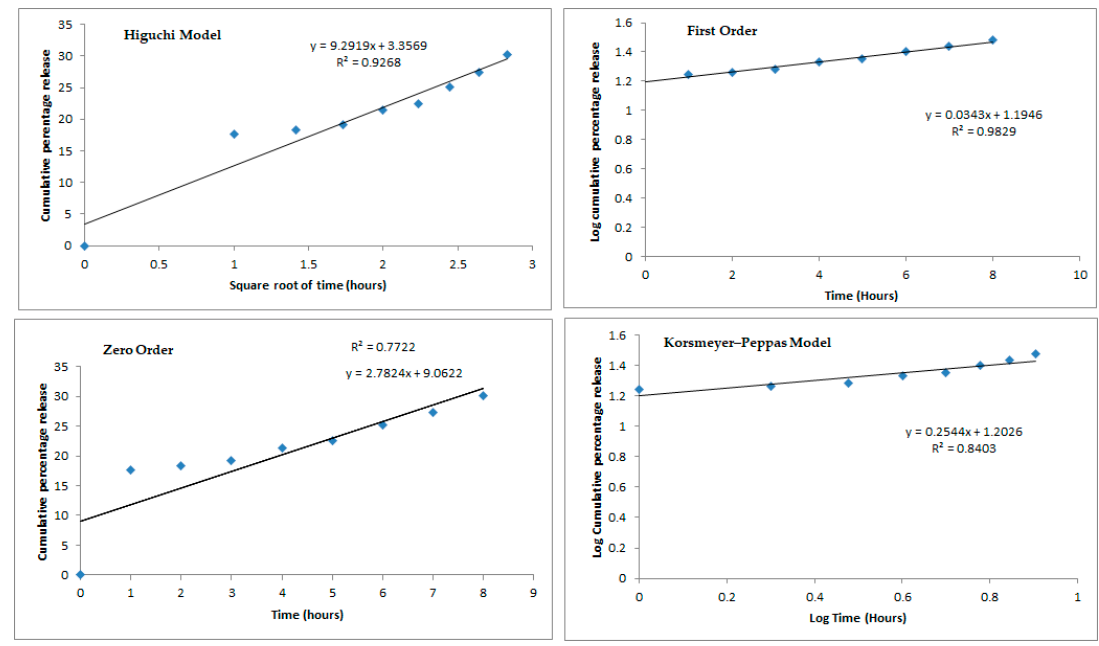
Figure 3. Mathematical fitting models (i.e. Higuchi Model, First Order, Zero Order and Korsemeyer-Peppas Model) of the release profile of sucupira oil from NLC (Formulation n ° 6) over 8 h.